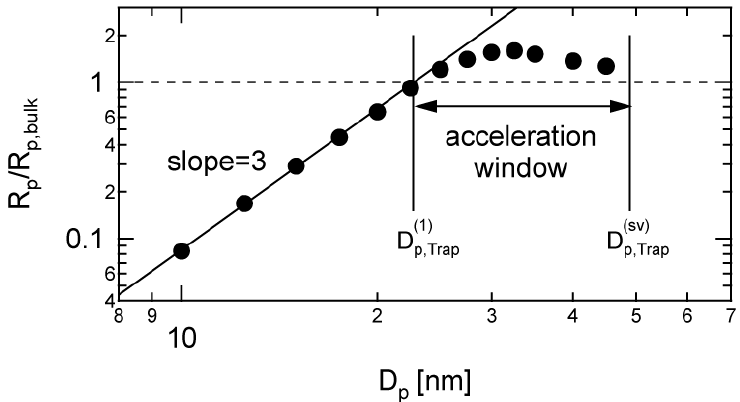
Figure 2. Calculated polymerization rate at 10% conversion for a model stable-radical-mediated polymerization (SRMP) miniemulsion polymerization with various particle diameter, D . The original calculated data shown by the symbols were taken p from